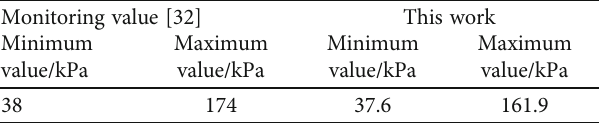
Table 4: Comparison of